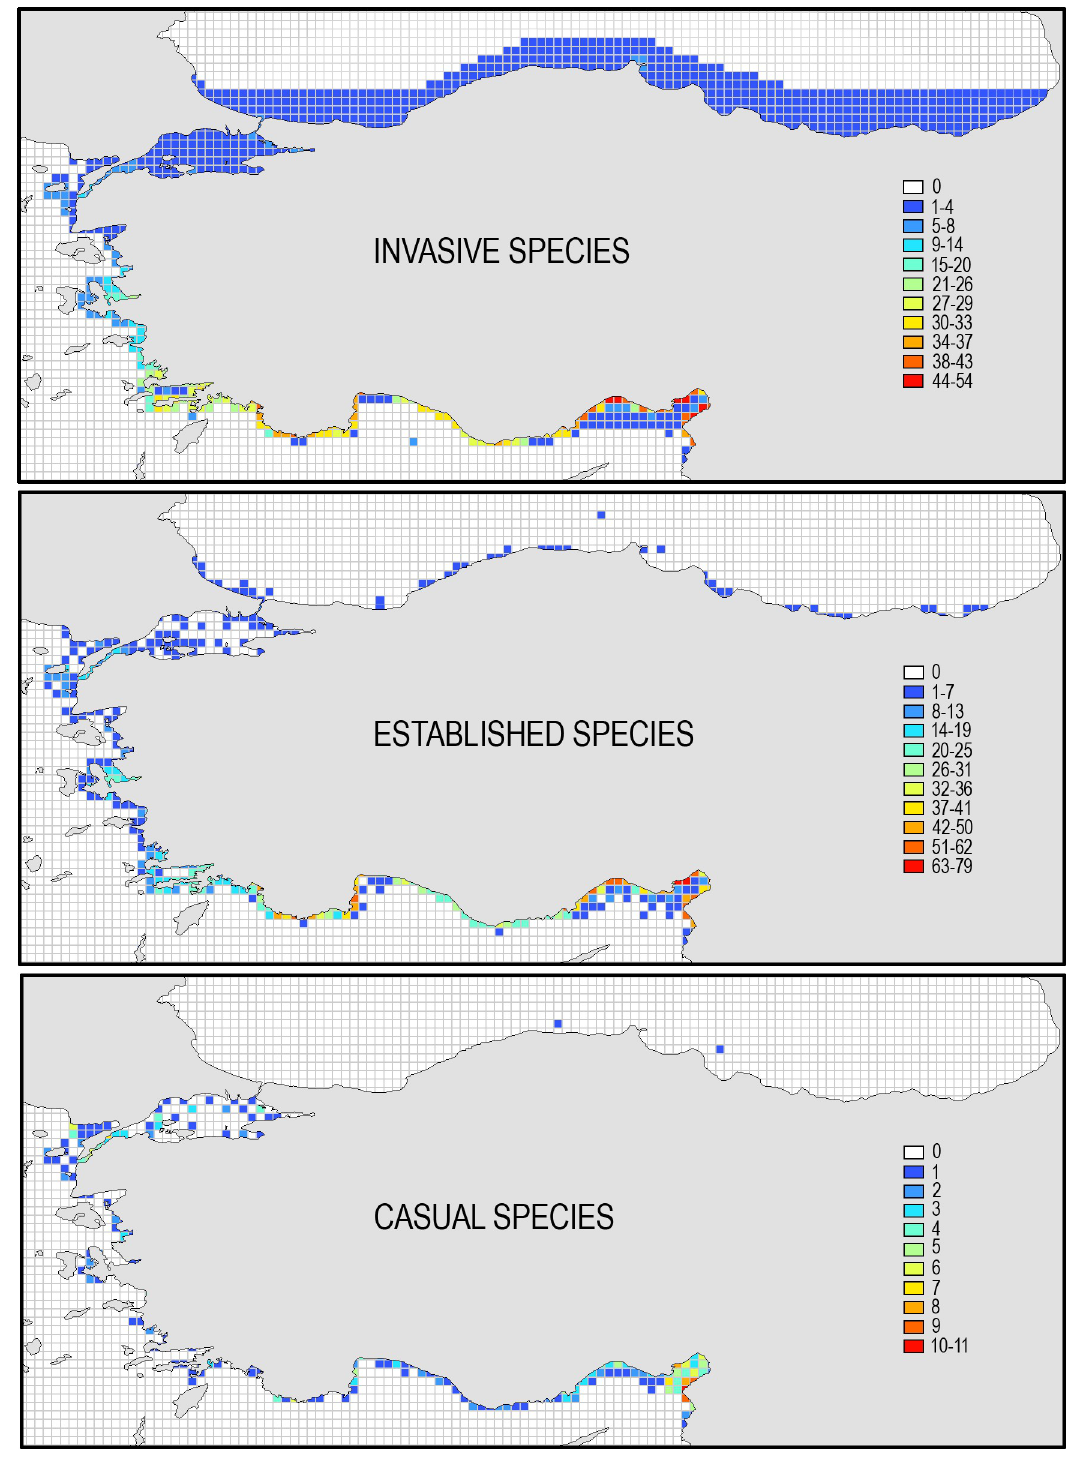
Fig 6. The distribution of invasive, established and casual alien species along the coasts of Turkey.